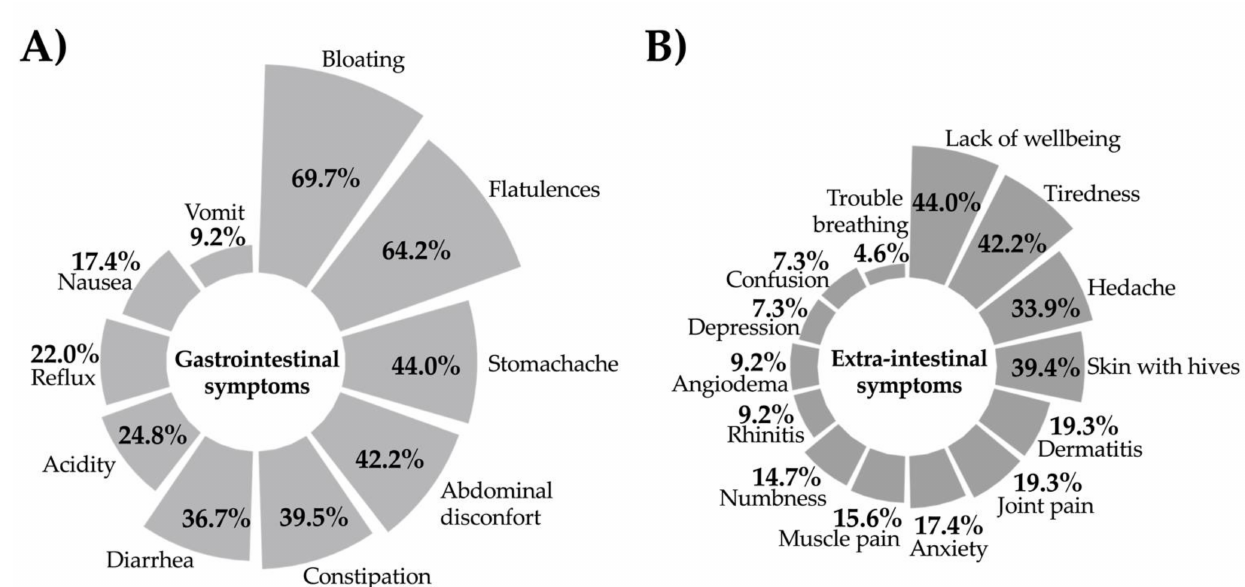
Figure 2. Self-reported ( A ) gastrointestinal and ( B ) extra-intestinal symptoms in SR-GS individuals (n =